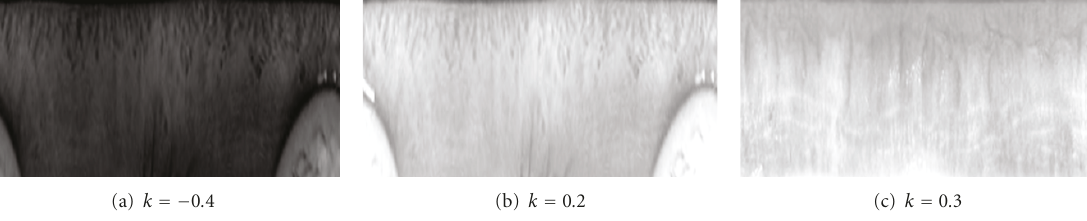
Figure 14: Examples of illumination variations. (a, b) CASIA image, (c) ISEP image.